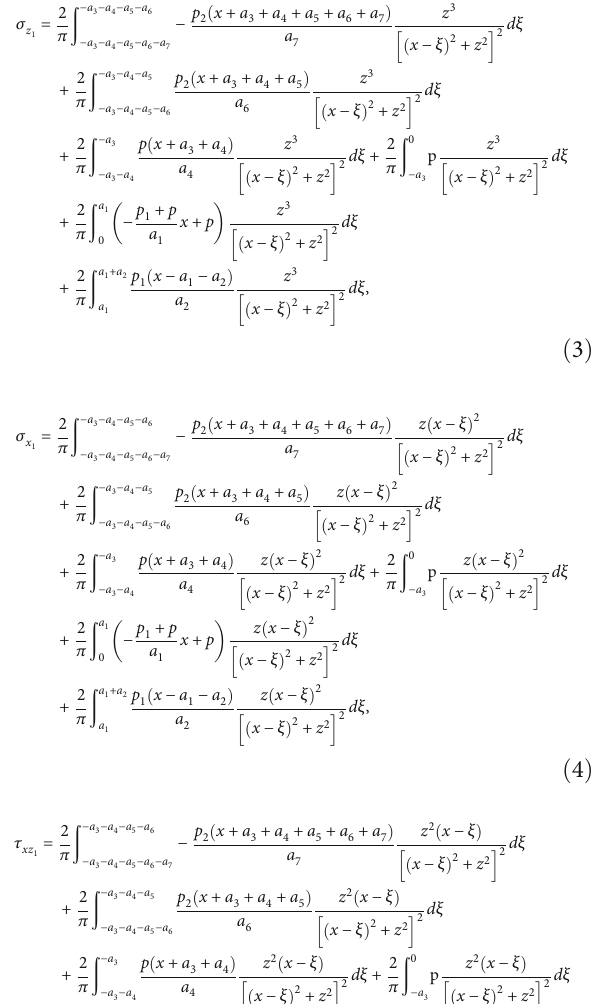
Figure 4. The vertical stress, horizontal stress, and shear stress all decrease gradually as the vertical distance h increases. The horizontal stress and shear stress decrease sharply, while the vertical stress decreases slowly. The stresses at 10, 20, and 30 m are 14.25, 9.687, and 7.62 MPa, respectively, and the stress concentration coe ffi cients are 1.8, 1.54, and 1.42, respectively. The additional stress values at 10, 20, and 30 m are 5.767, 3.132, and 1.7 MPa, respec- tively, and the stress concentration coe ffi cients are 1.32, 1.176, and 1.096, respectively. The shear stress also gradually returns to the original rock stress as the distance increases, indicating that the in fl uential ranges of the horizontal and shear stresses are small. However, the in fl uential range of the vertical stress is larger and decreases rapidly within a cer- tain depth range. When the depth exceeds 30 m, the vertical stress is the mainly contribution to the stress, and the value of the vertical additional stress is close to 0 at 90 m below the